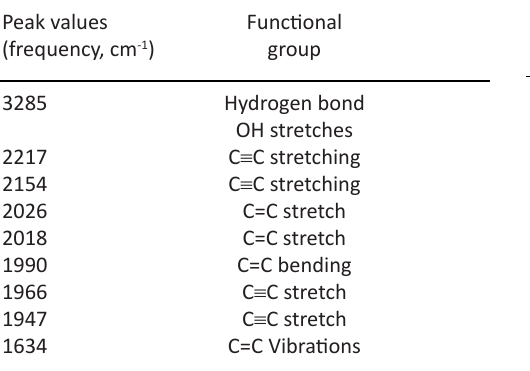
Table 7. FTIR spectrum of the methanol extracts of L. nobilis leaves.